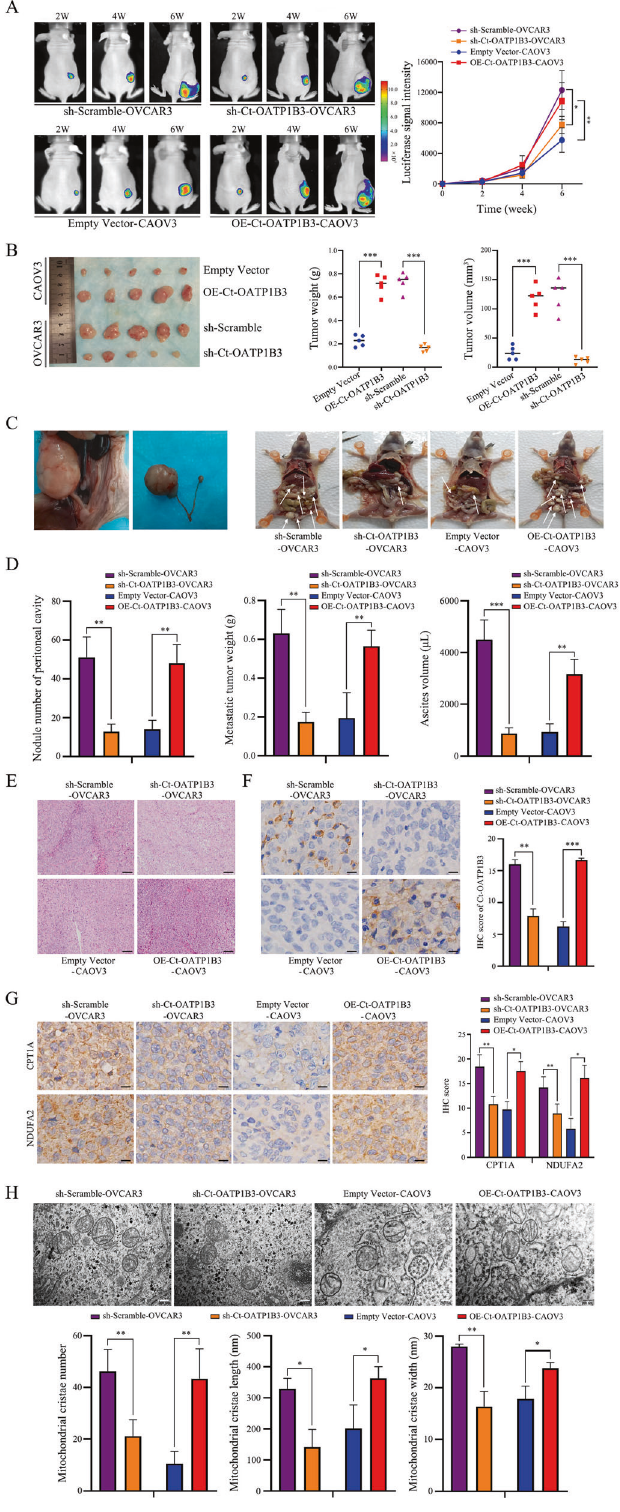
tube and ovarian surface epithelium are cells-of-origin for HGSOC [30]. Despite extensive research efforts, very few prognostic markers and therapeutic targets of HGSOC have been successfully implemented into clinical practice so far [31].